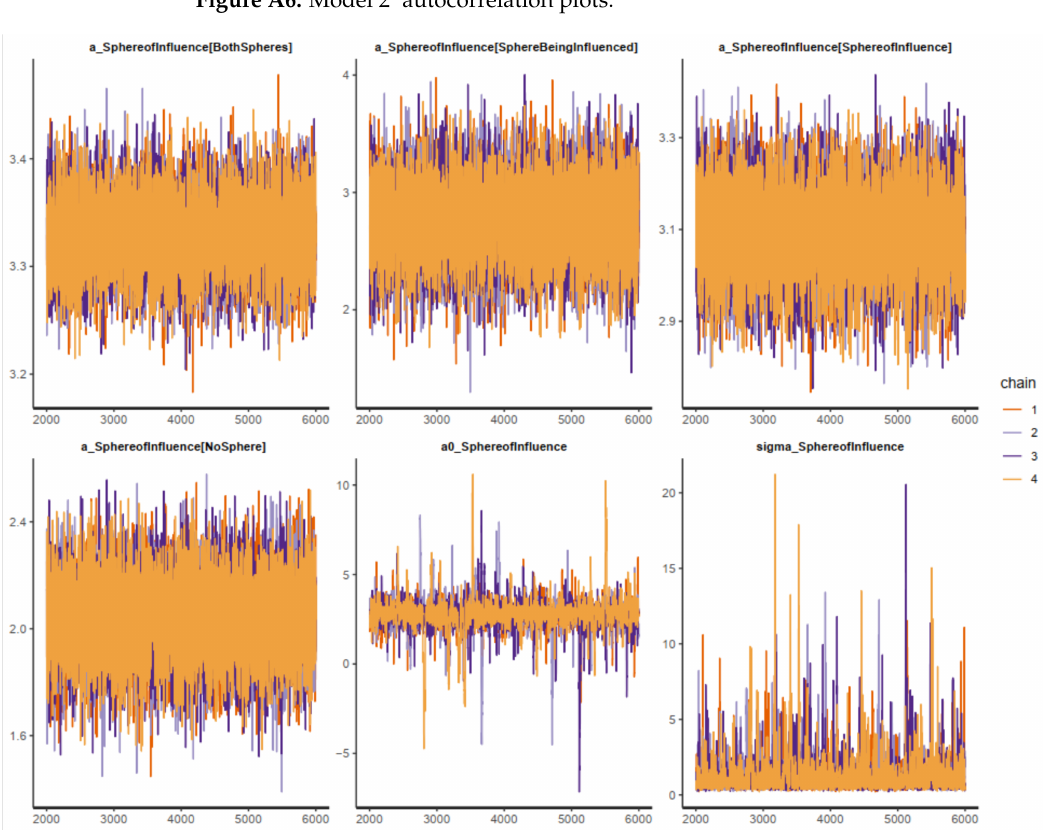
Figure A7. Model 3 (cid:48) s trace